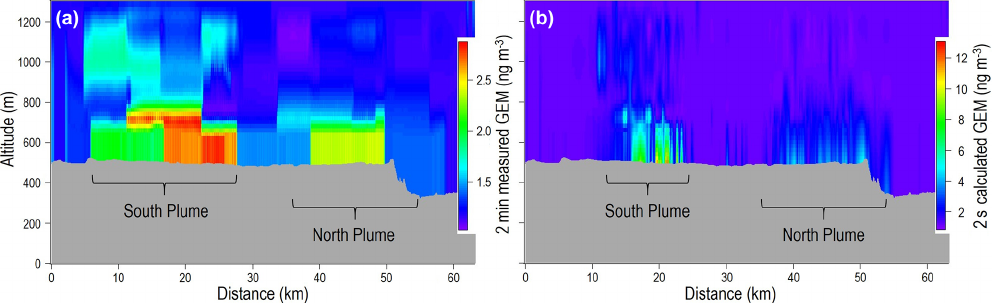
Figure 5. Simple kriging interpolation of TERRA GEM concentration screen for screen 1 of the GLP fires. Panel (a) is based on the 2min measured GEM concentration data. Panel (b) is based on the 2s GEM concentration calculated by conversion of the 0.5Hz CO data using the GEM : CO emissions ratio (ER). Note concentration differences between the 2min and 2s GEM concentration data in the figure